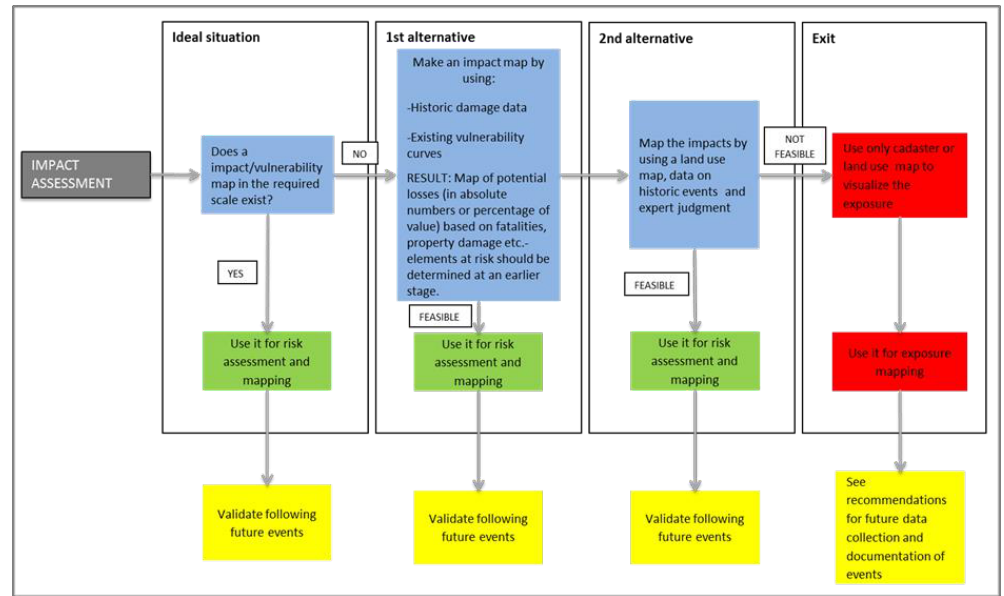
Figure 9. Quantitative impact assessment using alternative steps [46].